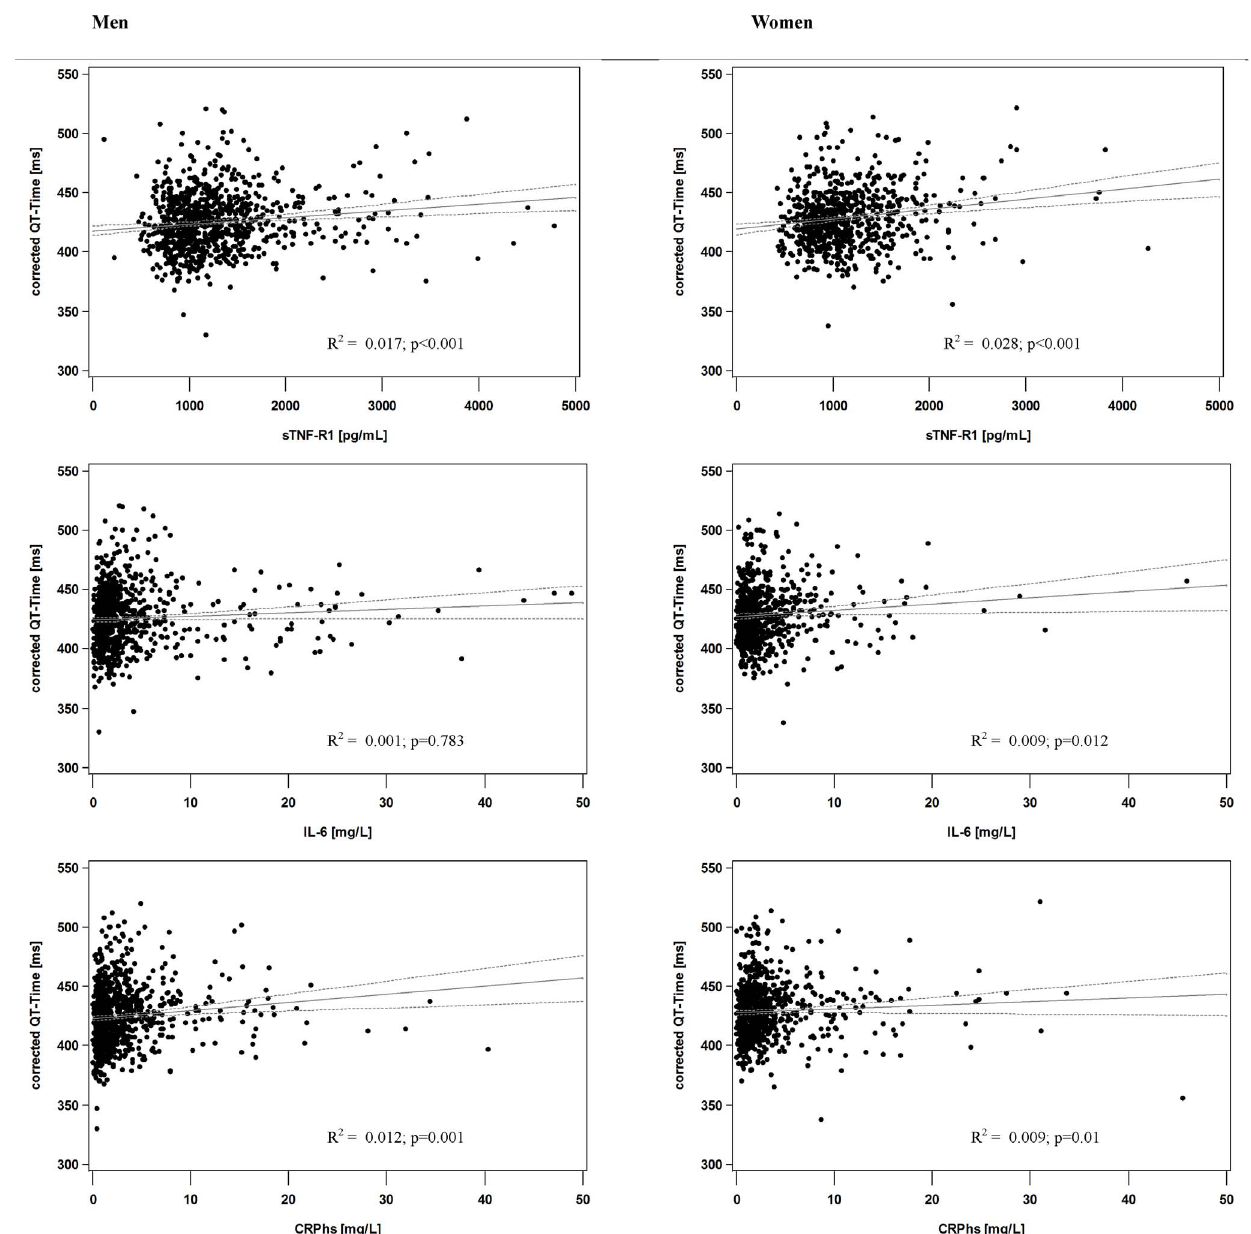
Figure 3. Scatter plot of corrected QT time dependent on sTNF-R1. x-axis: Soluble tumor necrosis factor type 1 (sTNF-R1) in pg/mL; y-axis: heart rate corrected QT time (QTc) in